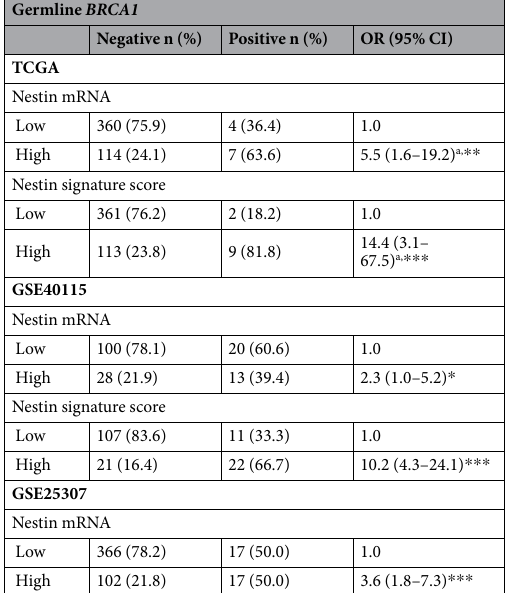
Table 4. BRCA1 germline mutation by Nestin mRNA expression and Nestin mRNA signature score (microarray data). a Fisher’s exact test. n: number of patients; OR: odds ratio; CI: confidence interval; P-values by Pearson’s chi-square test, * < 0.05, ** < 0.01, *** < 0.001. BRCA2 germline mutated patients are excluded from the analysis. Cut-off value: high: ≥ upper quartile. Missing data: BRCA -status: TCGA: n = 23, GSE25307: n =